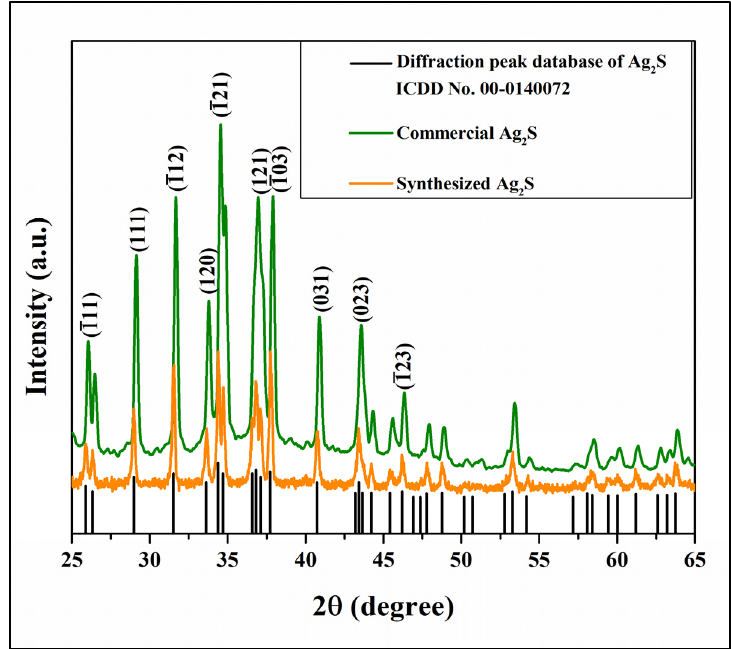
Figure 4. X-ray diffraction spectrum of synthesized Ag 2 S.